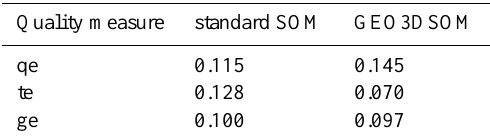
Table 3. Quality measures for the theoretical data